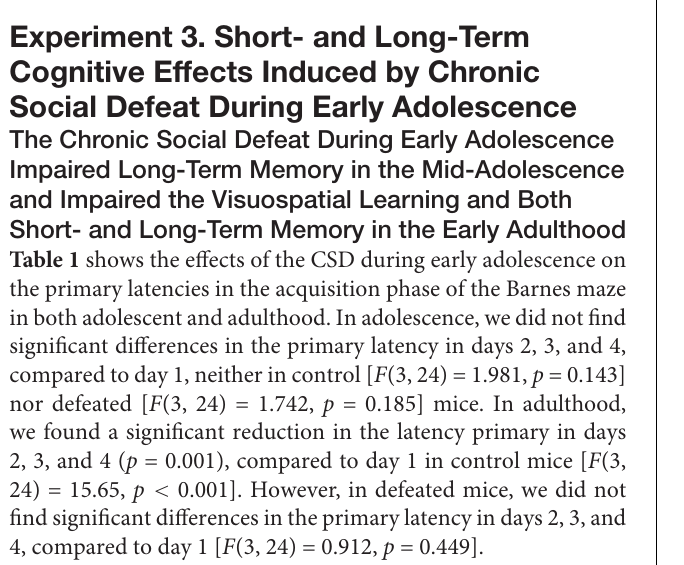
regression between serum corticosterone content and the age of mice (at 5 days intervals). We observed a significant decrease in